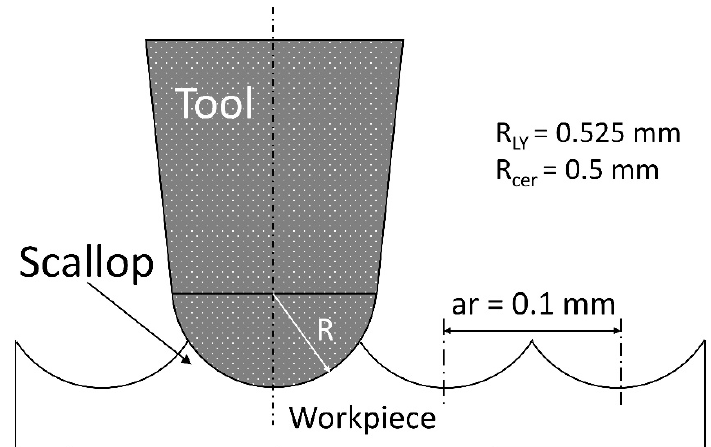
Figure 9. Geometric model of the 2D roughness obtained with the 2 tools tested in end milling mode.